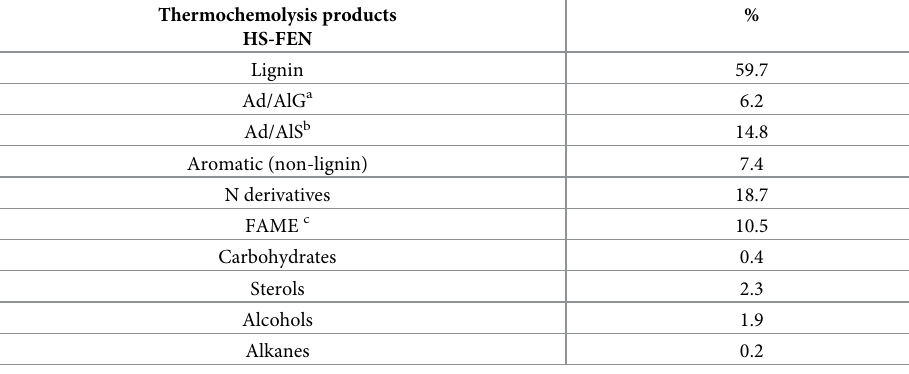
Table 2. Relative yield (%) of main thermochemolysis products a released from